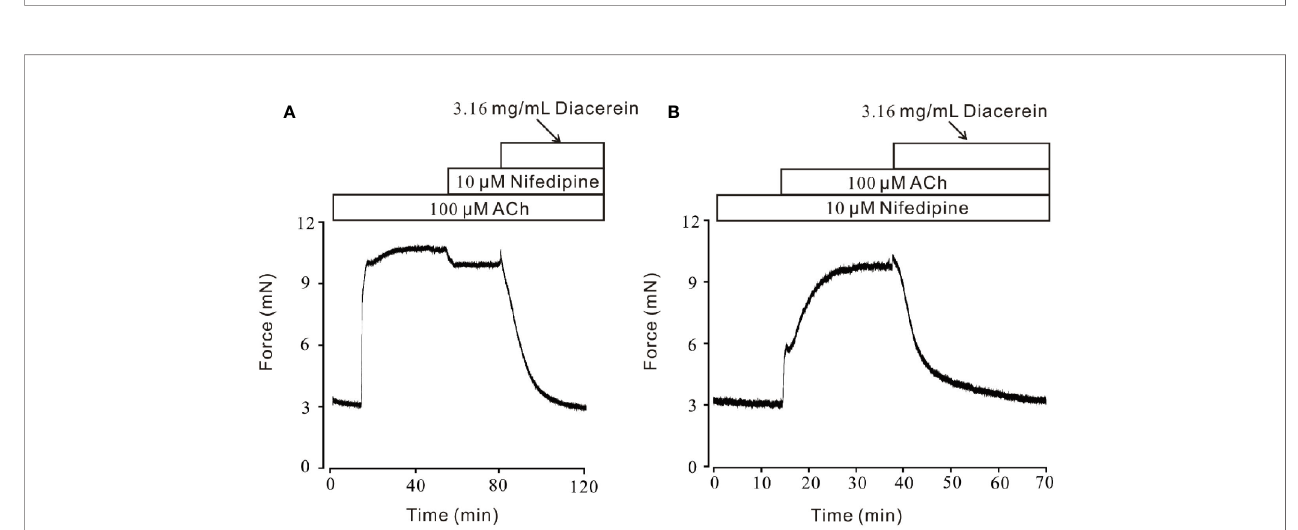
FIGURE 5 | Diacerein relaxed ACh-induced precontraction on mouse tracheal rings (mTRs) after blocking voltage-dependent L-type Ca 2+ channels (VDLCCs) with nifedipine. (A) ACh-induced contraction was partly reversed by 10 m M nifedipine. The remaining contraction was completely inhibited by 3.16 mg/ml diacerein, subsequently (n = 6/6 mice). (B) In the presence of 10 m M nifedipine, ACh-induced contraction was inhibited by 3.16 mg/ml diacerein (n = 6/6